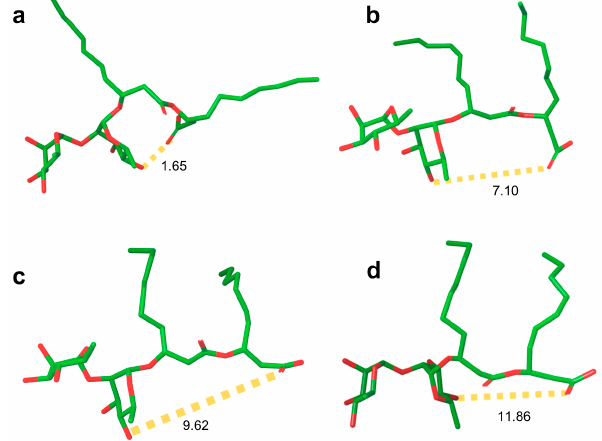
Figure 3. Representative spatial arrangements of di-rhamnolipid molecule (Rha-Rha-C 10 -C 10 ) ob- tained as result of molecular dynamic simulation highlighting headgroup conformational flexibility. The three structures differ for the potential energy value: ( a ) 39.019 kJ/mol (medium energy) (corre- sponding to the closed conformation described by Luft et al. [189]), ( b ) 38.892 kJ/mol (local minimum energy) (corresponding to the open conformation described by Luft et al. [189]), ( c ) 37.967 kJ/mol (global minimum energy), ( d ) 42.255 kJ/mol (highest energy). The H-bond distance between the carboxyl group and the -OH at position C4 of the first rhamnose is explicitly shown. The structures were built using the Built facility in Maestro program in the Schrödinger suite (Maestro, Schrödinger, LLC, New York, NY, USA). MD parameters: AMBER* force field, water as solvent, at 298 K, 100 ns simulation time, monitoring 10,000 structures.